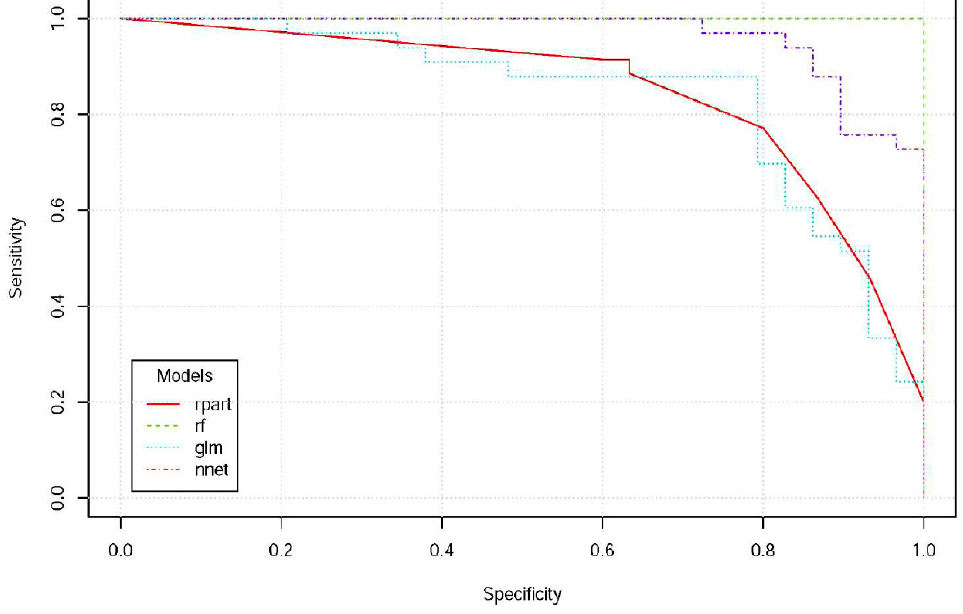
Figure 4. Receiver operating characteristic curves for lung cancer predicted by environmental exposure histories and exposure biomarkers in pleural fluid. We included the prediction variables of environmental exposure histories (lived near the main street, distance to the main street, cigarette smoking, incense burning, essential oil) and exposure biomarkers (PAHs and BTEX in pleural fluid) and used four machine learning algorithms to establish a prediction algorithm. The machine learning algorithms used R packages of the decision tree (rpart), random forests (rf), generalized linear models (glm), and neural networks (nnet). The ROCs ranged from 0.84 to 1.00.